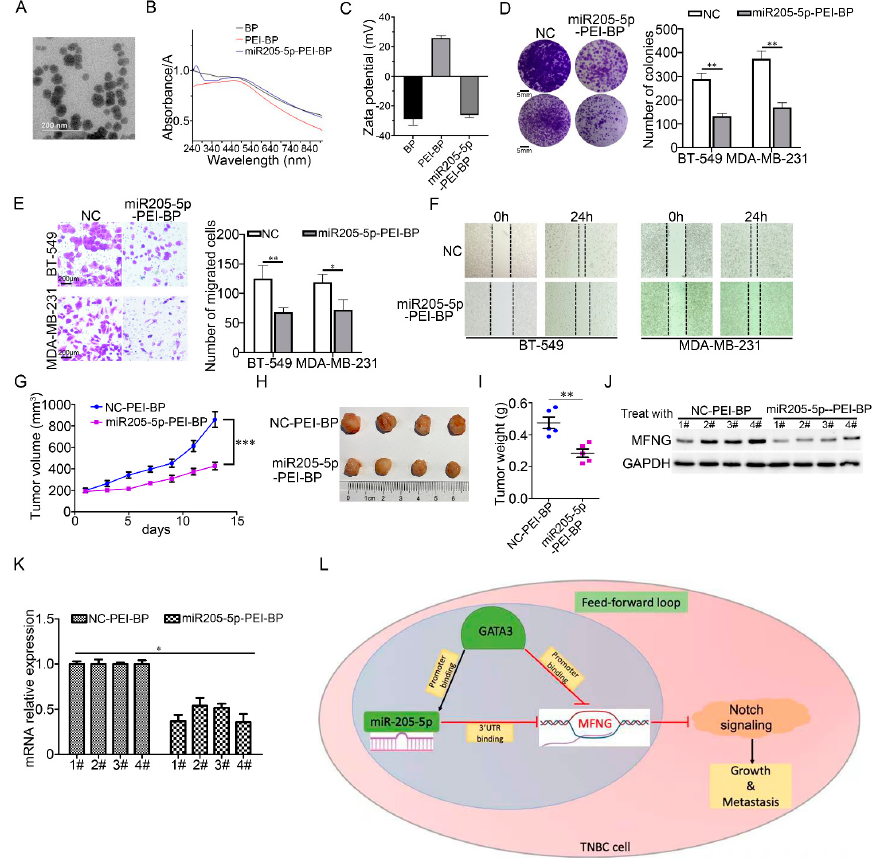
Figure 7. miR205-5p had potential in TNBC therapy. ( A ) Picture of miR205-5p-PEI-BP taken by transmission electron microscope, scale bar is 200 nm. ( B ) The light absorption spectrum of miR205- 5p-PEI-BP. ( C ) The zeta electric potential of miR205-5p-PEI-BP. ( D – F ) The effect of miR205-5p-PEI-BP on cell growth and metastasis was examined by clone formation, transwell, and wound-healing assays (5 nmol), NC was the negative control of miR205-5p. ( G ) A time course of tumor growth. The decrease in tumor volume of the mice treated with miR205-5p-PEI-BP compared to their negative controls. Mice were treated with NC-PEI-BP (5 nmol) or miR205-5p-PEI-PB (5 nmol) twice a week for two weeks. ( H , I ) Following the sacrifice of mice, tumors were removed, photographed, and tumor weight was measured. ( J ) Western blot and ( K ) RT-qPCR analysis confirmed that MFNG was downregulated in the tumors treated with miR205-5p-PEI-PB, and GAPDH served as an internal control. ( L ) A comprehensive summary of the GATA3-miR205-5p feed-forward loop mechanism that targets MFNG and inhibits tumor growth and metastasis in TNBC. Data were analyzed using a Student’s t -test. All * p < 0.05, ** p < 0.01, *** p <